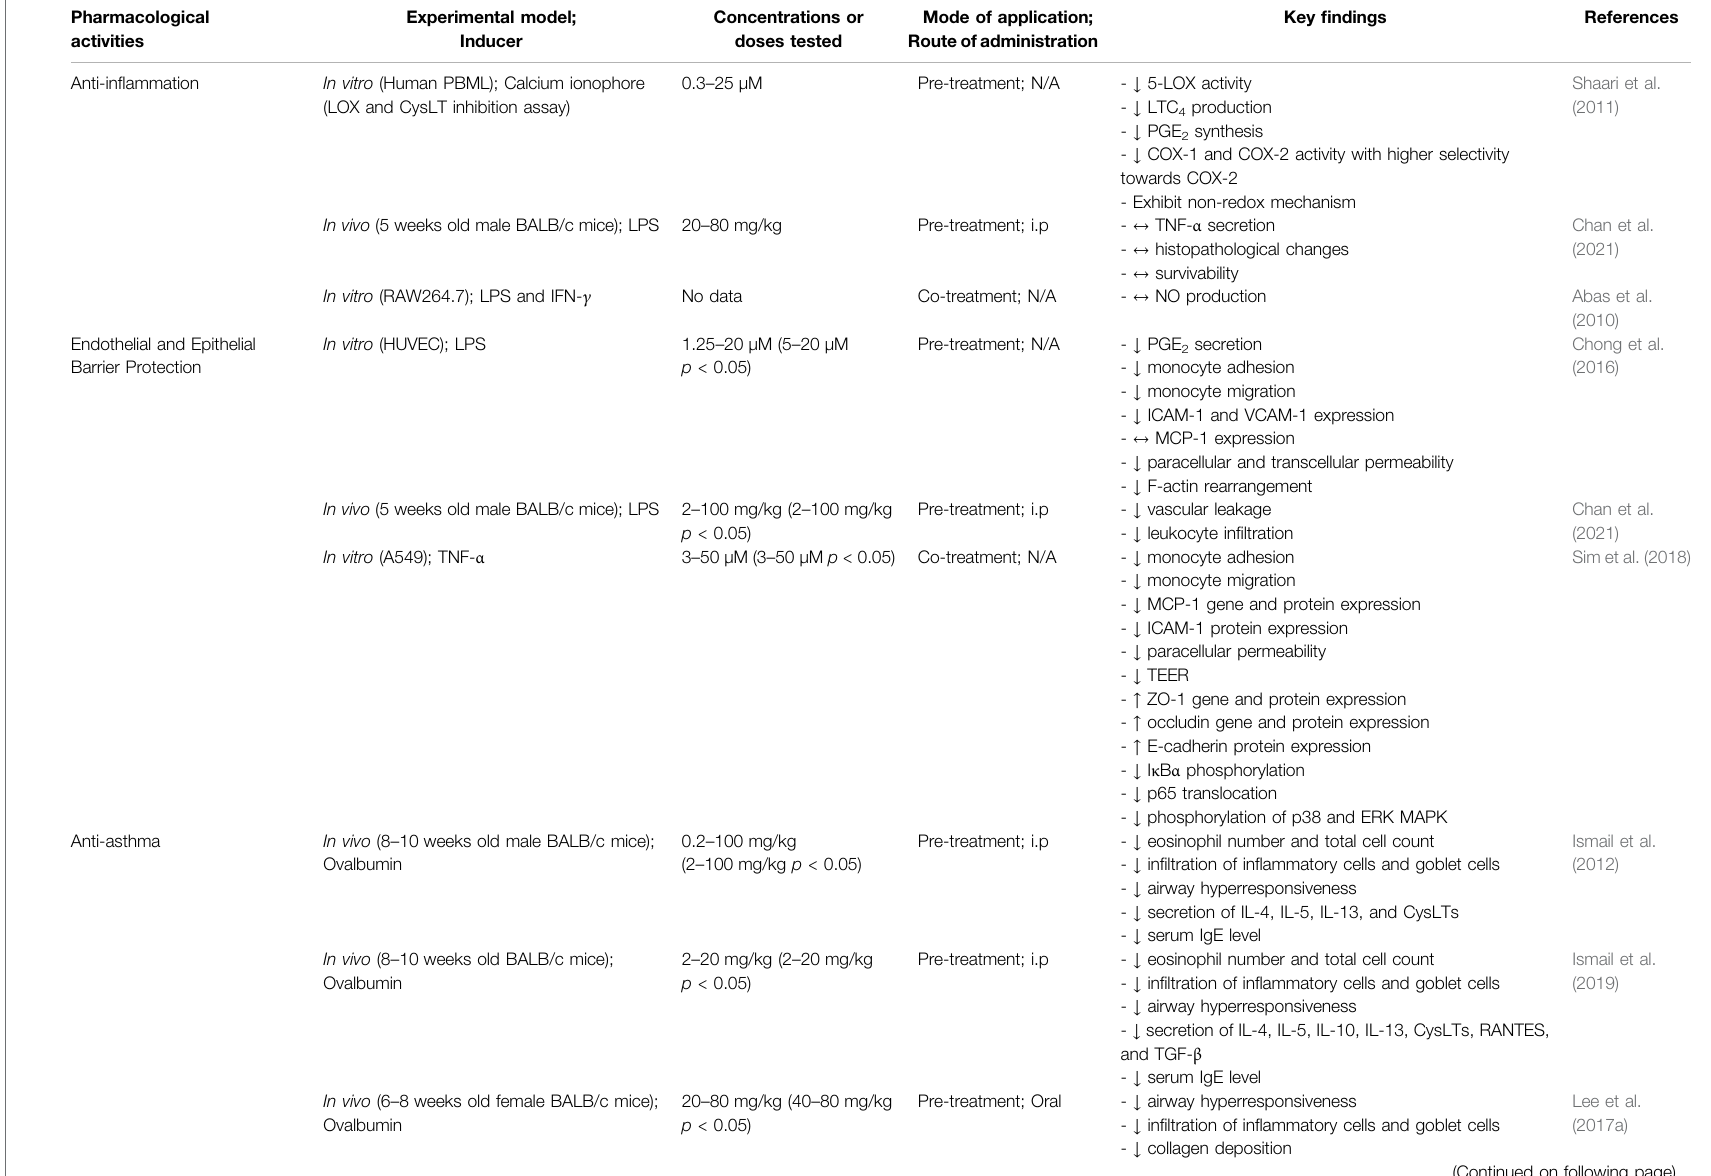
TABLE 1 | Pharmacological activities of tHGA and the key fi ndings reported in various studies with different experimental